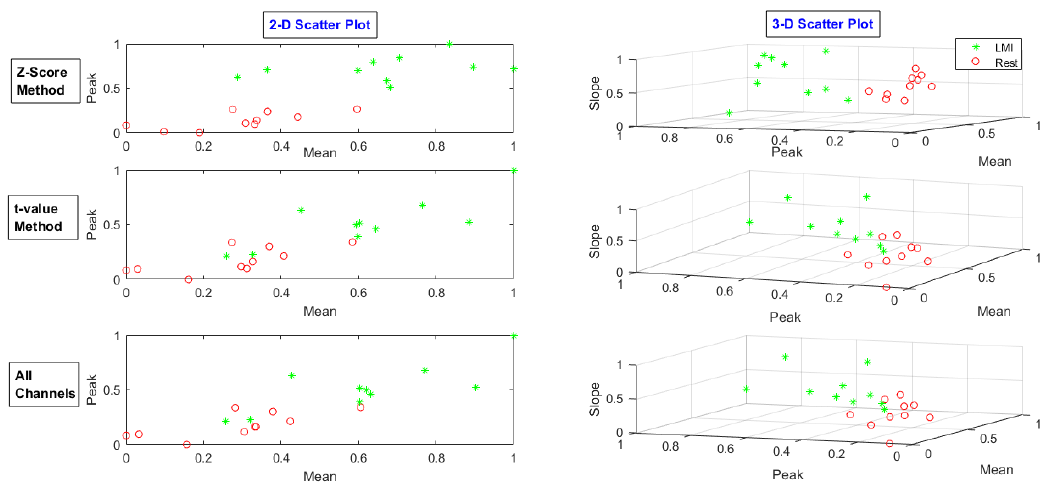
Figure 10. Feature scatter plot of the t -value-method-selected channels’ data, z-score-method-selected channels’ data, and all channels’ data for LMI task.